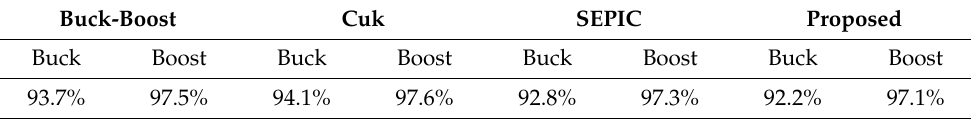
Table 2. Efficiency of the proposed topology compared to some other buck-boost converters. Buck-Boost Cuk SEPIC Proposed Buck Boost Buck Boost Buck